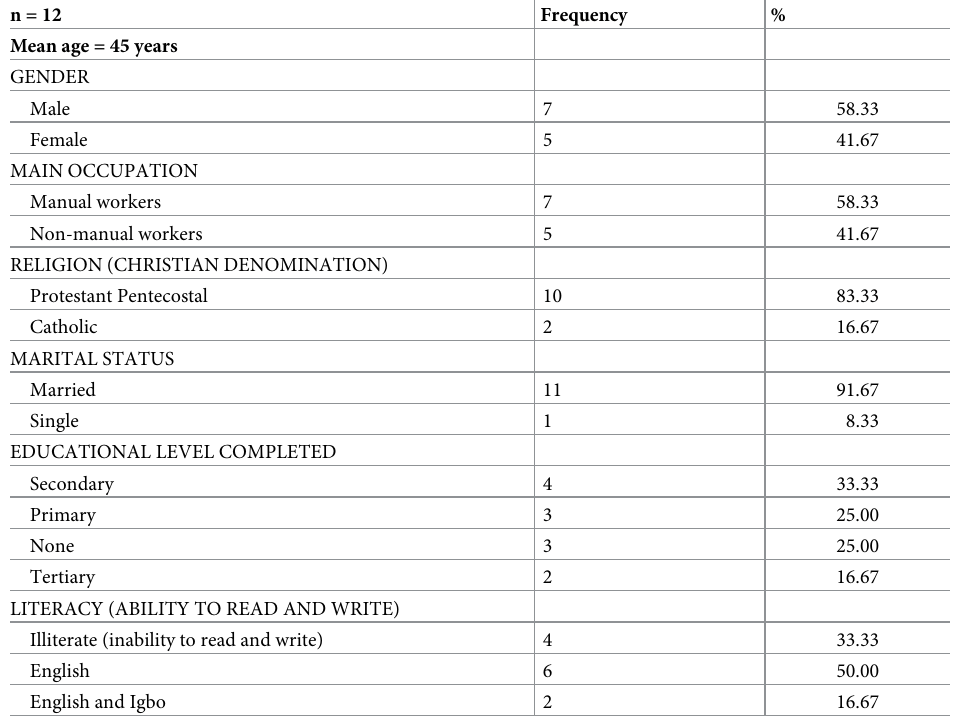
Table 1. Demographic characteristics of participants that pre-tested the questionnaire. n =